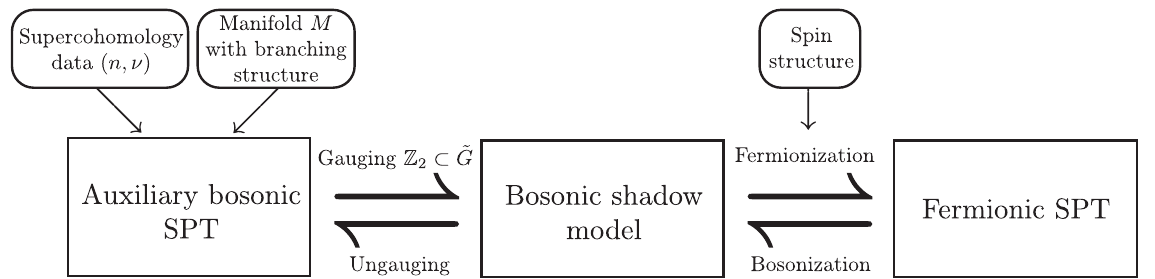
FIG. 1. Our construction of a fermionic SPT Hamiltonian begins with the input of supercohomology data and a choice of manifold M with branching structure. These data are used to build an auxiliary bosonic SPT protected by a ˜ G to obtain the bosonic shadow model — a G -symmetry-enriched toric code. Finally, with a choice of spin structure, we subgroup of fermionize the bosonic shadow model to arrive at the G protected fermionic